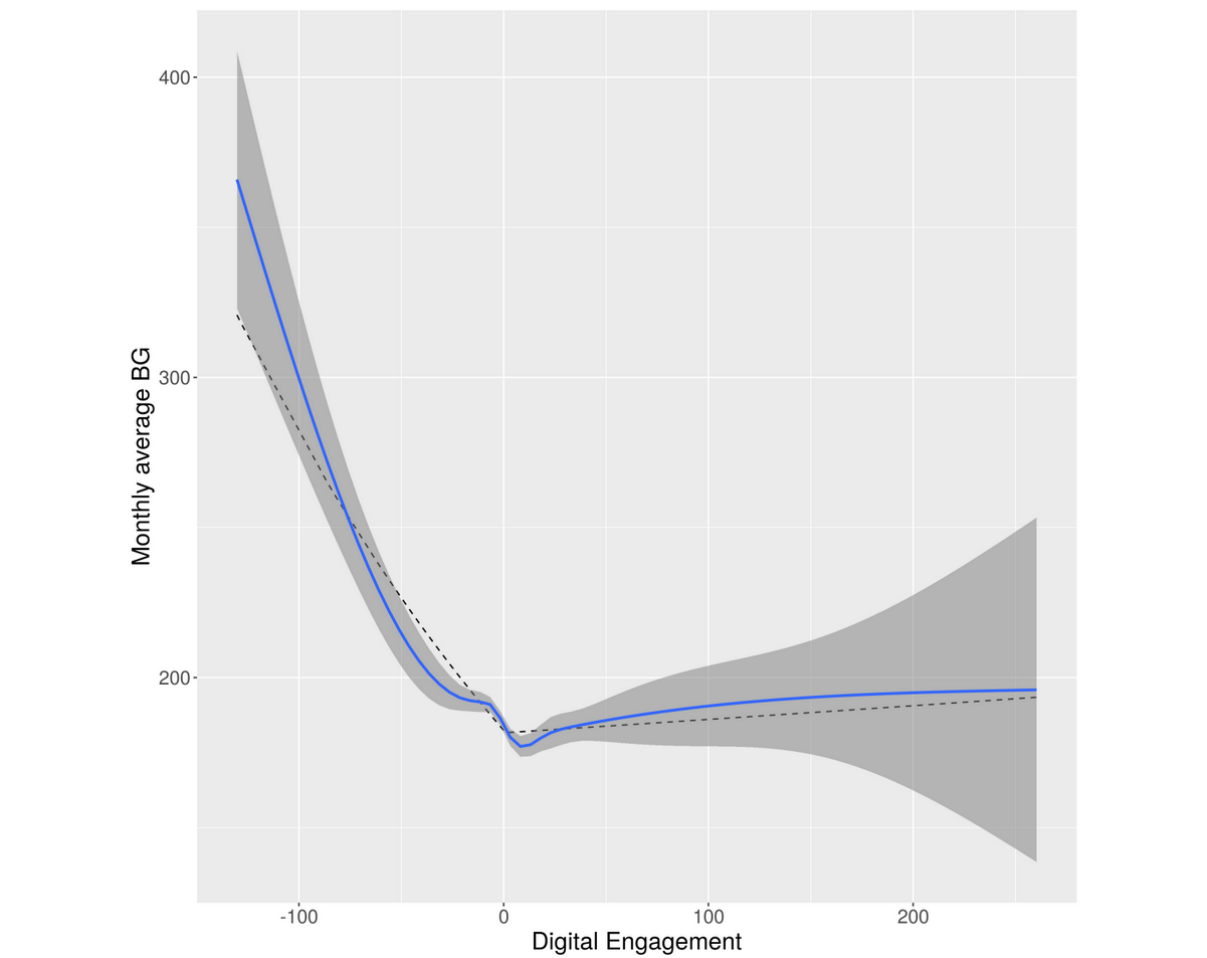
Figure 3. Association between within-person 1-month lagged digital engagement and monthly average blood glucose (BG) (mg/dL). The blue line shows locally weighted smoothing with a 95% confidence interval (the surrounding dark grey area). The dotted gray line indicates results from the generalized mixed piecewise model with two slopes (below and above the person-level